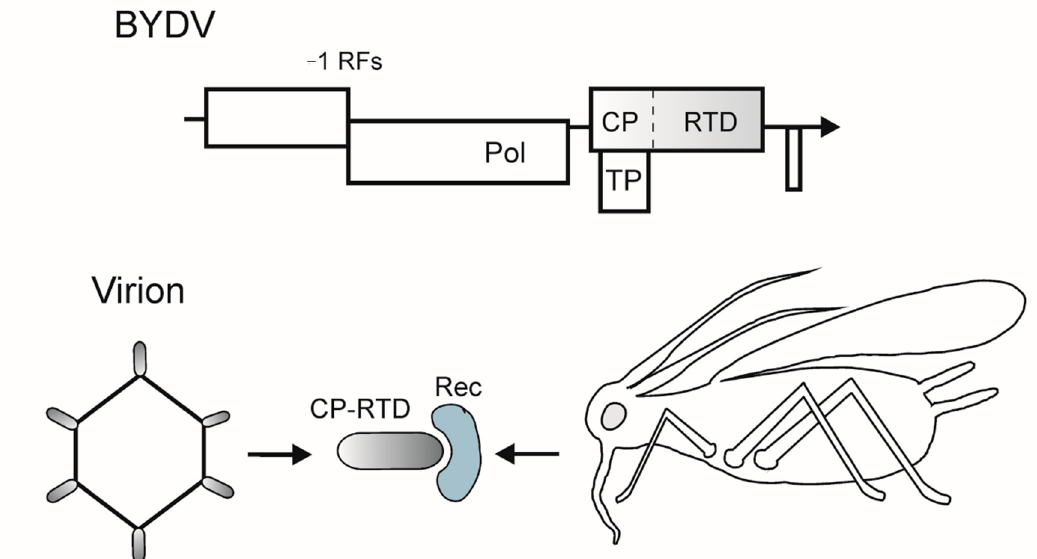
Figure 2. Top, scheme of the genomic RNA of barley yellow dwarf virus (BYDV). − 1 RFs, − 1 ribosomal frameshifting signal for translation of replication-associated genes. Vertical dotted line, leaky stop codon in the CP gene. Encoded proteins and protein domains: Pol, RNA-dependent RNA polymerase; TP, long distance transport protein; CP, capsid protein; RTD, readthrough domain. The genes involved in vector transmission are shaded. Arrow indicates the 3 ′ -end of RNAs. Bottom, scheme of the protein interactions in luteovirus transmission. The CP-RTD assembles into the particles and interacts with an aphid receptor (Rec).